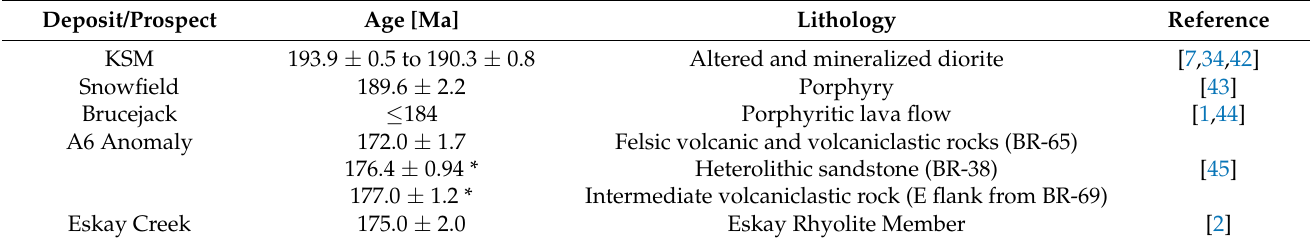
Table 1. Age of mineral deposits in vicinity of study area and of the A6